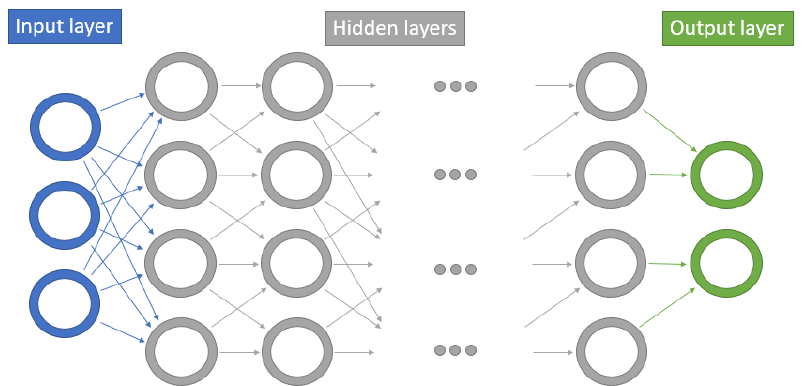
Figure 2. Neurons, layers and signal transmissions.